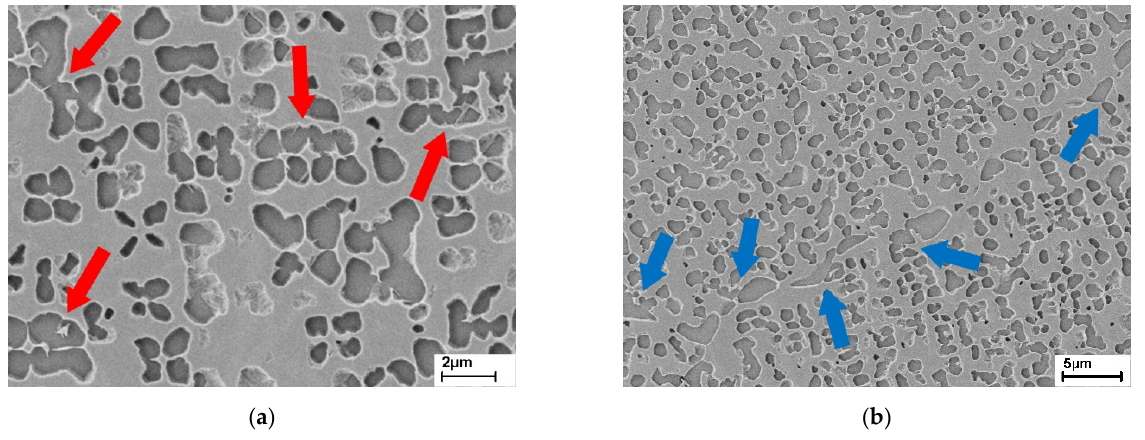
Figure 5. Bicontinuous γ / γ′ microstructure: ( a ) detail from Figure 2a: cross-linking of the octodendritic γ′ -precipitates (red arrows); ( b ) detail from Figure 3a: grain boundaries with big precipitates and narrow ligaments of the matrix; blue arrows indicate links of the grain boundary precipitates to γ′ particles in the grain interior.